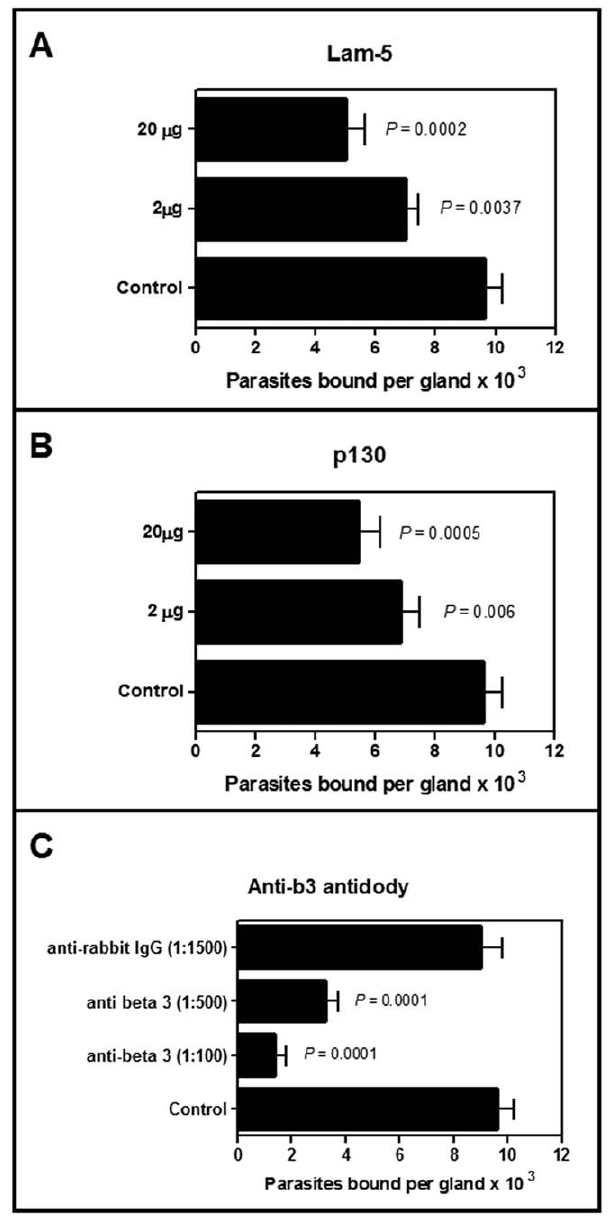
Figure 9. Inhibition of the in vitro interaction between Phytomonas serpens and salivary glands explanted from Oncopeltusfasciatus . The parasites were pre-incubated for 30 min in the presence of human laminin-5 (Lam-5) ( A ) or in the presence of the purified 130 kDa salivary gland protein (p130) ( B ). In a parallel system, the salivary glands were pre-incubated in the presence of anti-human laminin-5 b 3 chain antibodies (anti- b 3 antibodies) ( C ). In the control systems, the parasites and salivary glands were pre-incubated in the absence of the proteins and antibodies, respectively. The proteins and antibodies were used at the indicated concentrations or dilutions. Each bar represents the mean 6 standard error of at least three independent experiments. The P values are indicated on the